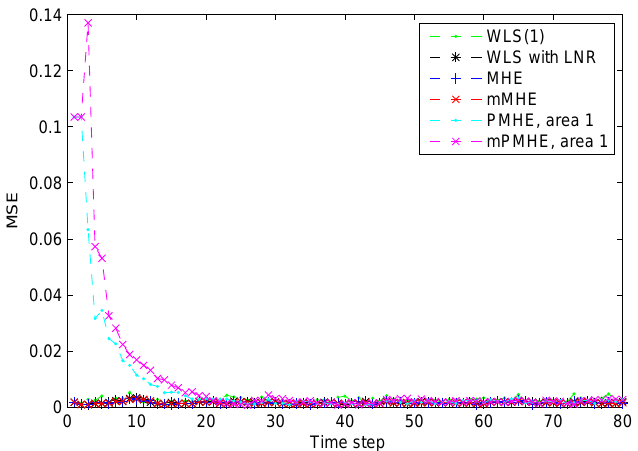
Figure 3. The Mean Square Error (MSE) of WLS(1) (the horizon length of measurements 1), MHE, mMHE, PMHE and mPMHE with constraints, under the assumption of Gaussian noise.